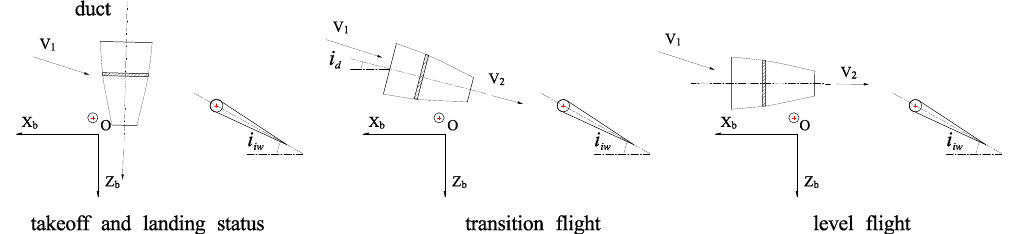
Figure 3. Duct deflection in three flight states.